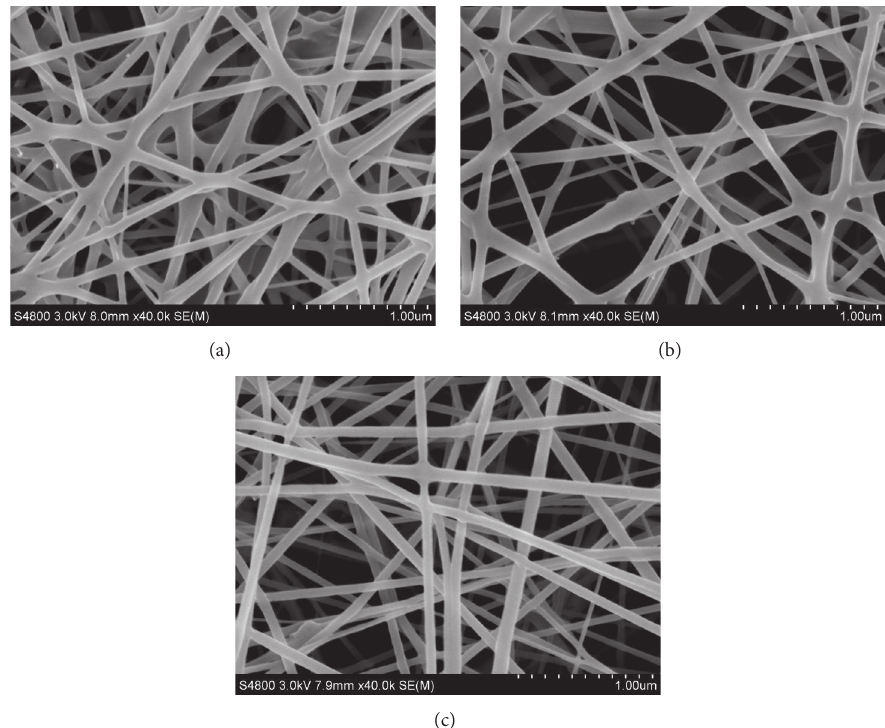
Figure 3: SEM micrographs of the blend nanofibers obtained using various weight ratios of keratin to PVA: (a) 50/50, (b) 60/40, and (c)